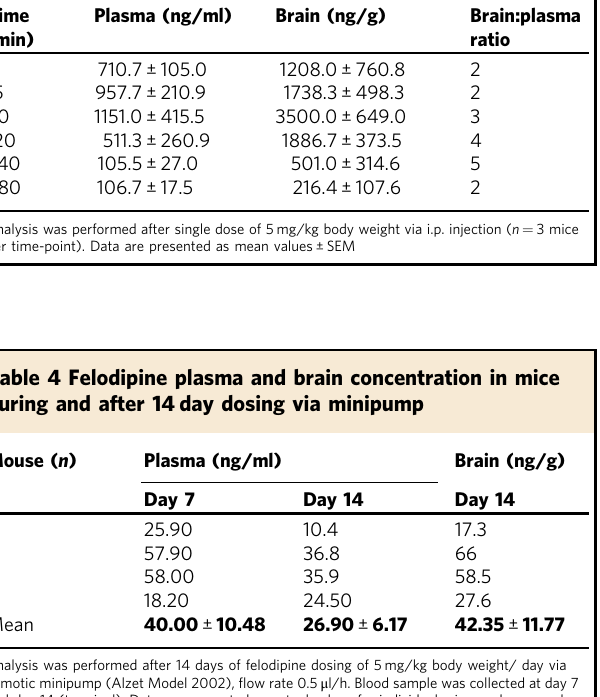
Table 2 PK parameters of felodipine in mice PK parameter